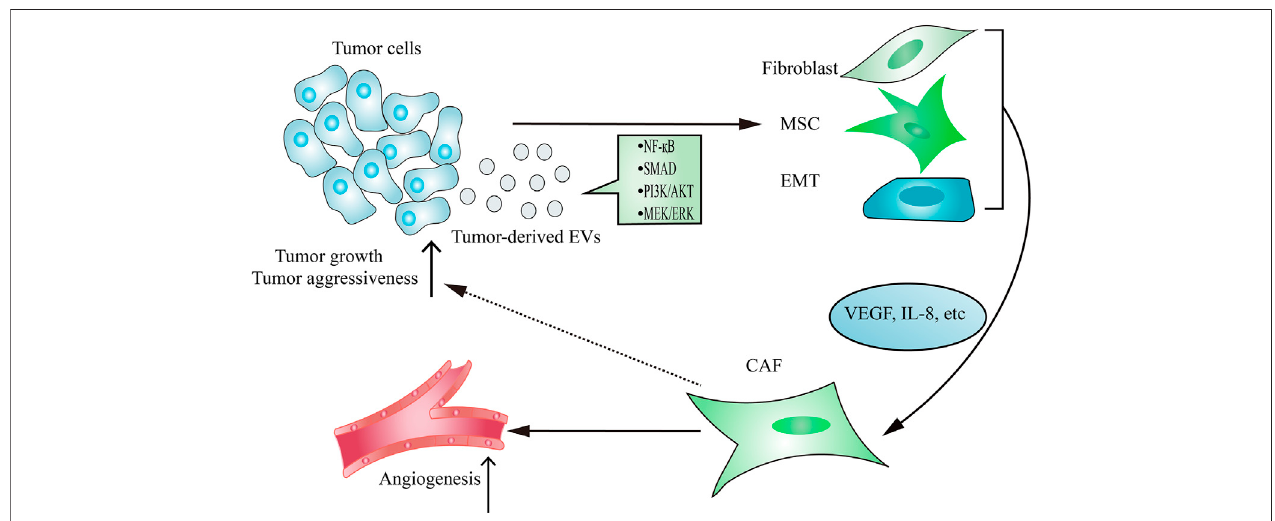
FIGURE2| Tumor-derived EVsregulateCAFstransformation.Thedeliveryoffunctionalsignaling factors fromtumor cellsto fi broblasts, MSCsorEMTcontributes to CAFs transformation, which consequently promotes tumor growth and aggressiveness and induces angiogenesis.